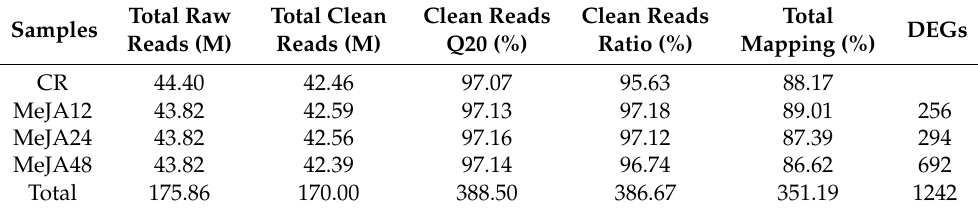
Table 1. RNA-seq raw data and number of differentially expressed transcripts. Samples